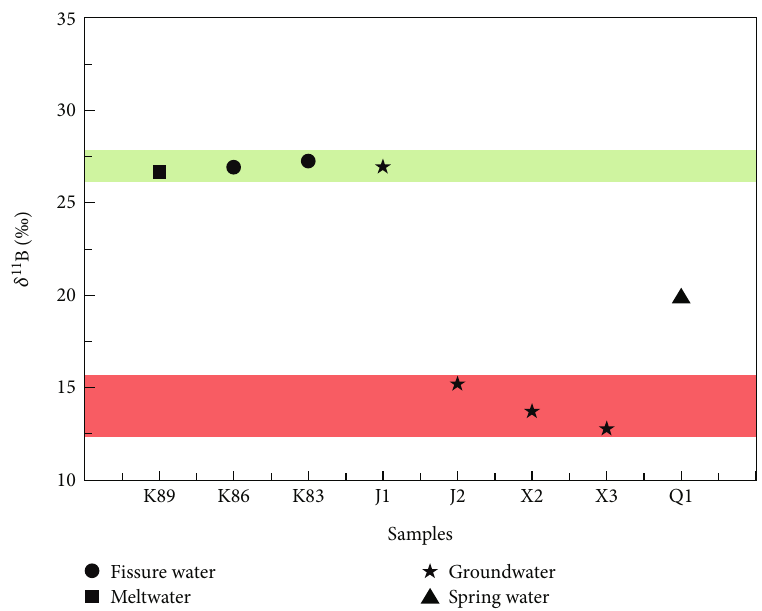
Figure 4: Boron isotopic composition of water in the Kumish basin. The green and red areas in the fi gure indicate the boron isotopic composition ranges of component 1 and component 2,